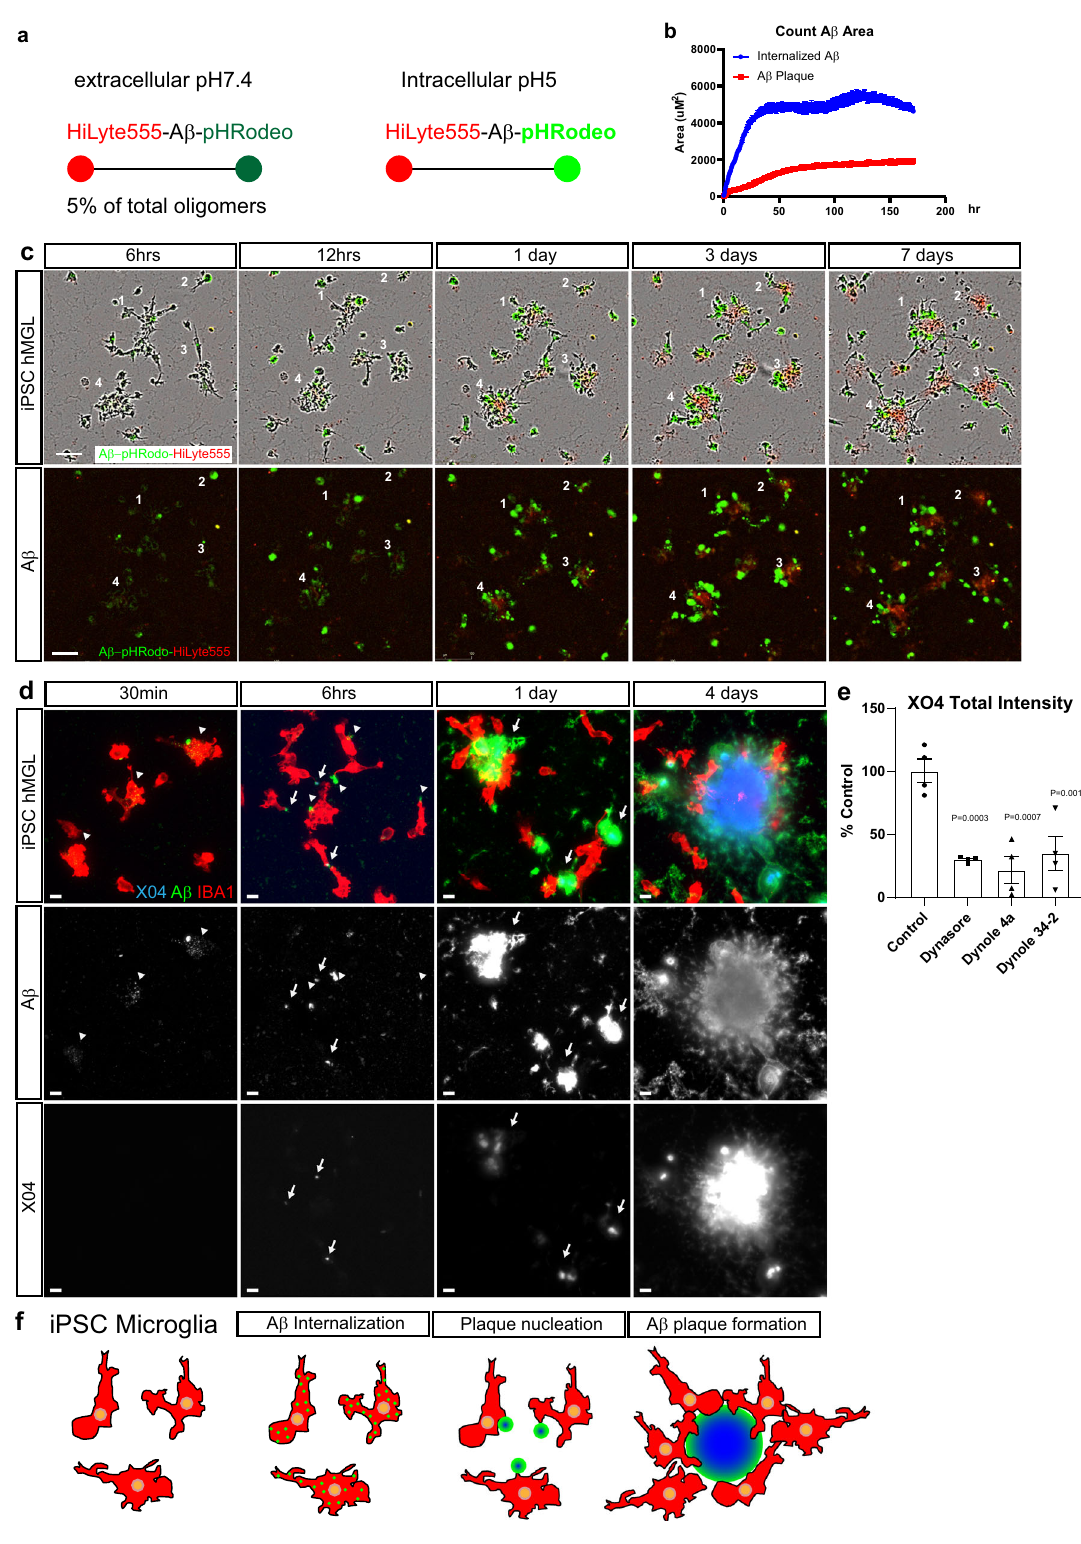
single exposure (Fig. 7a – c, solid vs dotted line). We chose repe- ated doses of 0.625 μ M to model AD progression, which took 21 days to cause cell